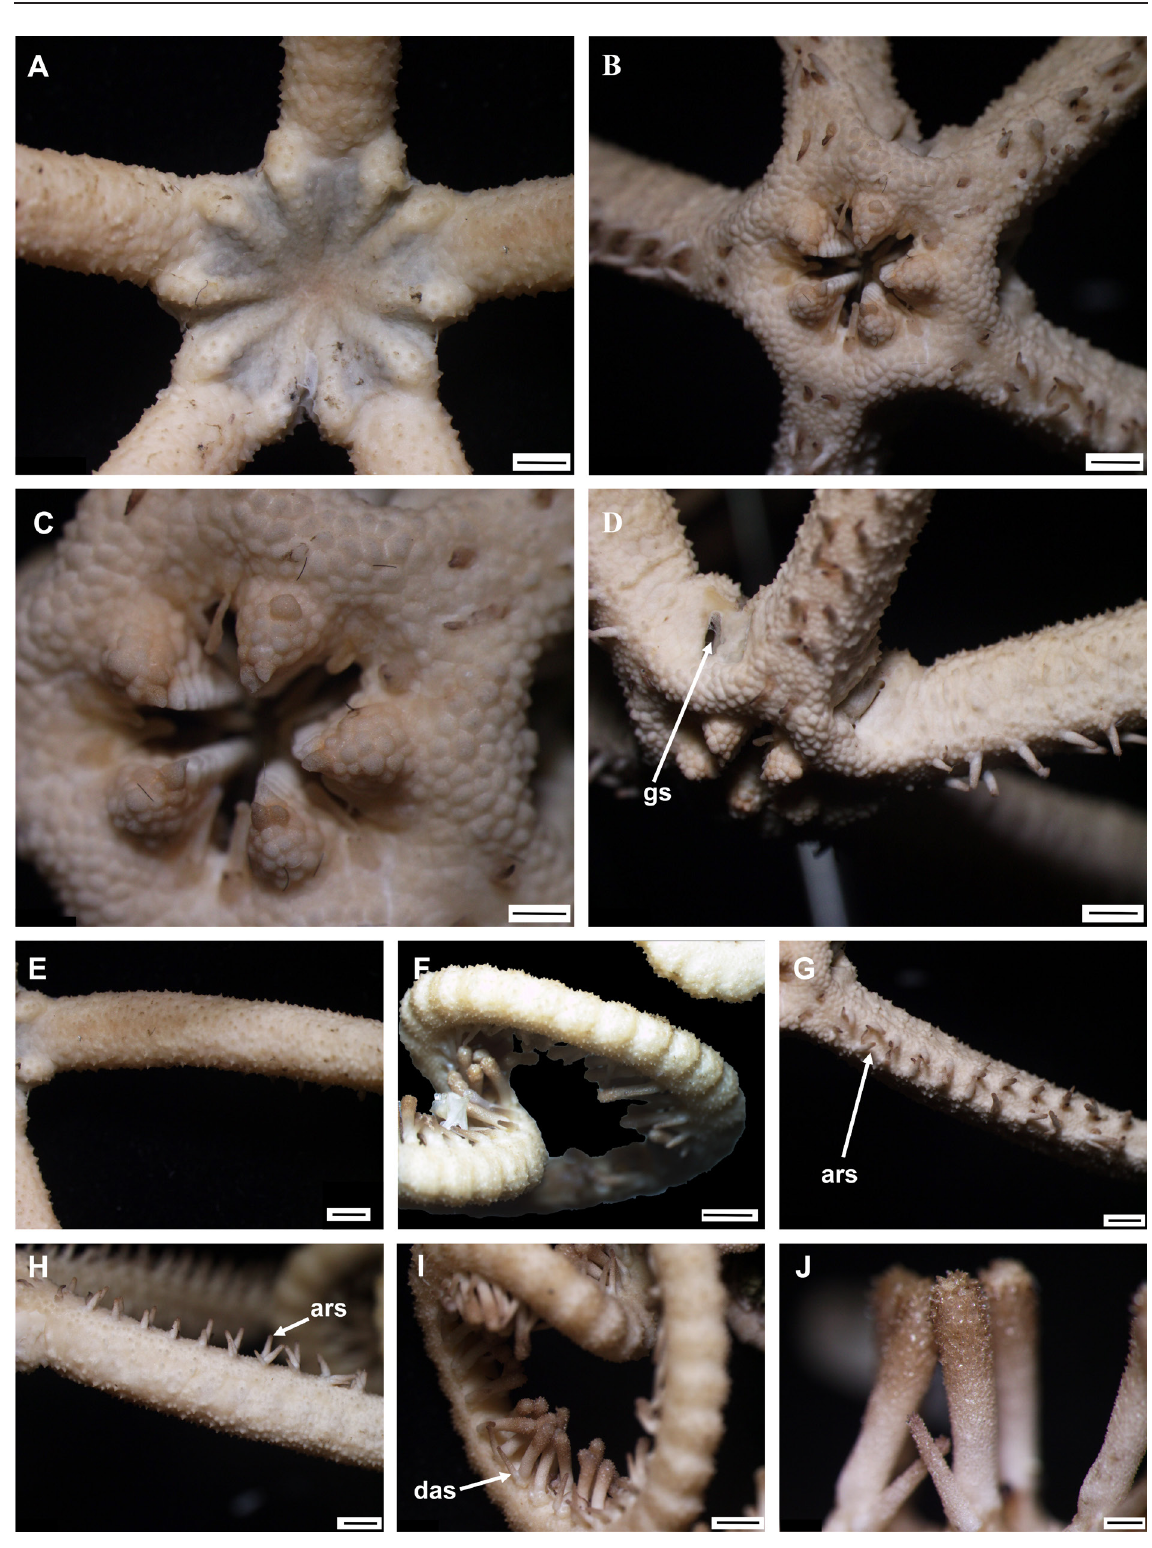
Fig. 7. Asteroschema horridum Lyman, 1879 (IDSSE EEB-SW0005). A . Dorsal disc. B . Ventral disc. C . Oral frame. D . Lateral disc. E–F . Dorsal arm (proximal and distal regions). G . Ventral arm. H . Lateral arm. I . Ventral arm. J . Ventral arm spine. Abbreviations: ars = arm spine; das = dorsal arm spine; gs = genital slit. Scale bars: A–B, D–I = 2 mm; C = 1 mm; J = 500